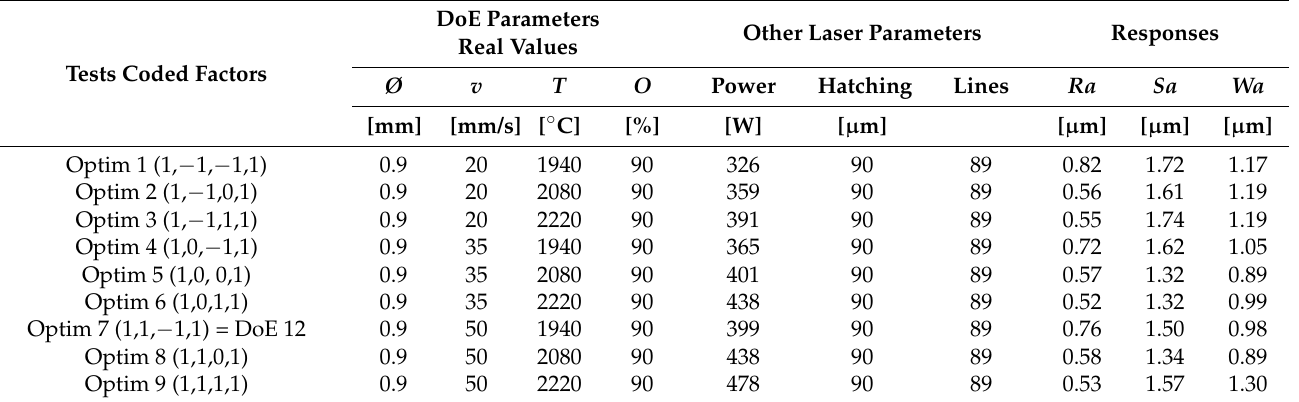
Table 4. Matrix of experiments for the DoE optimization including the coded values (first column) of the main parameters and the actual values (columns 2–5), other laser parameters calculated from the main parameters (column 6–8) and the responses issued from topography measurements (last 3